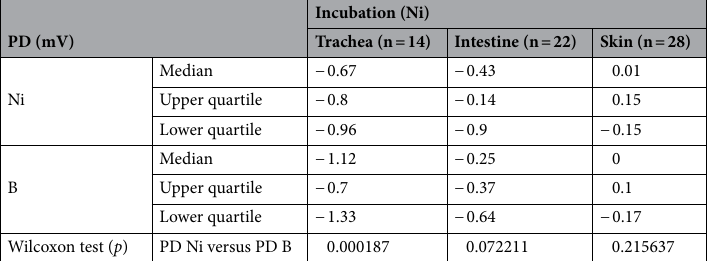
Incubation (Ni) Trachea (n = 14) Intestine (n = 22) Skin (n =